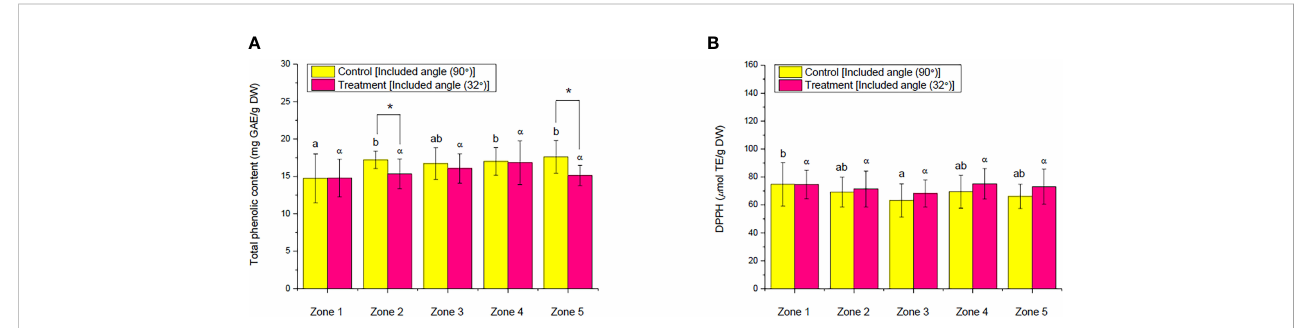
FIGURE 13 Comparison of the (A) total phenolic content and (B) 2,2-diphenyl-1-picrylhydrazyl of choy sum shoots at seedling stage on day 16 grown in an indoor farm rack with and without the application of an adjustable lampshade-type re fl ector (ALR). Different Greek alphabets ( a and b ) and the lowercase letters (a, b, and c) indicate signi fi cant differences among all the zones with and without the application of ALR ( N zone1 = 6, N zone2 = 6, N zone3 = 6, N zone4 = 6, p < N zone5 = 6, one-way ANOVA; Tukey multiple-comparison;